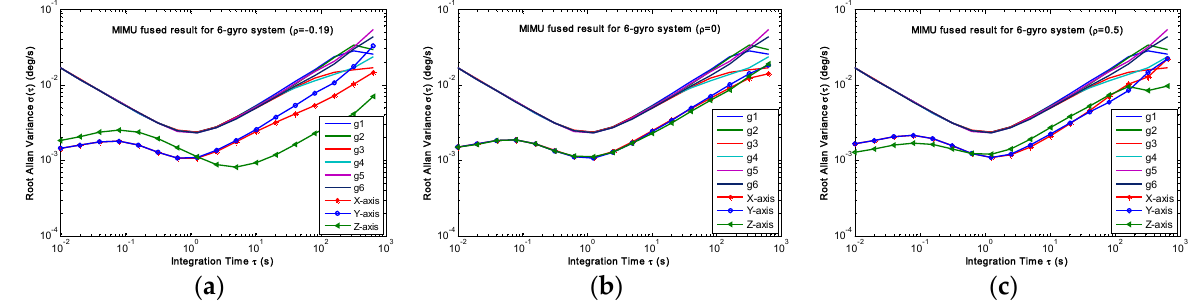
Figure 15. Plot of the compared Allan variance of 6-gyro MIMU for scheme 2: ( a ) ρ = − 0.19; ( b ) ρ = 0; ( c ) ρ = 0.5. Table 3. Results of Allan variance of 6-gyro MIMU for scheme 1.